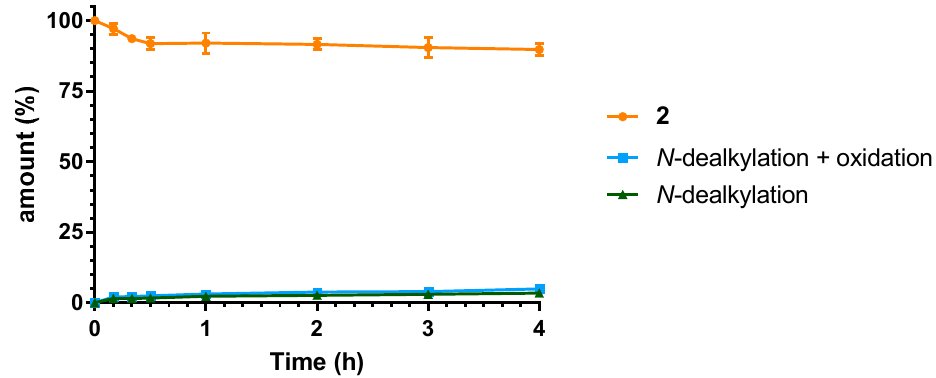
Figure 6. Metabolic stability of 2 and the formation of main metabolites ( N -dealkylation as well as oxidation and N -dealkylation of 2 ).